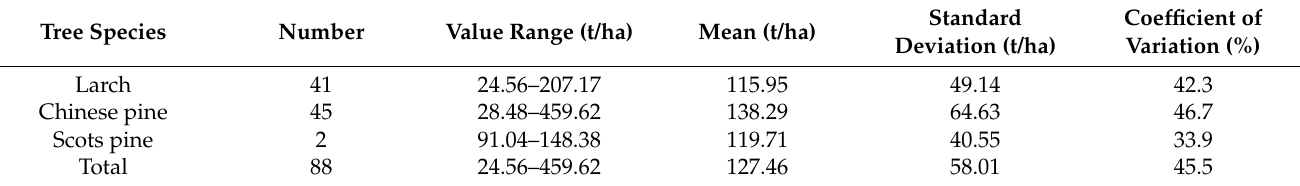
Table 1. Statistical results of measured AGB in Wangyedian forest farm. Tree